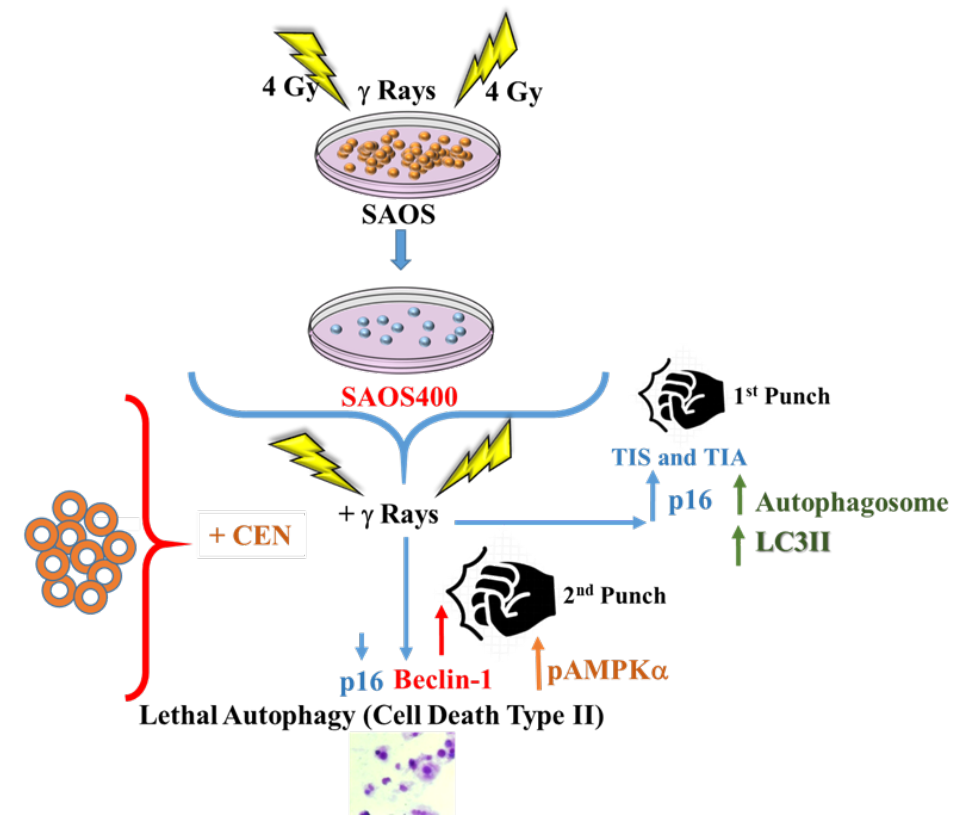
Figure 10. General scheme summarizing data obtained in the SAOS400 cell line after combined treatment with CEN and radiation. Therapy-induced autophagy and senescence can be seen as double-edged sword in the context of radioresistance: They can represent a form of contrast to cell death, but also a ‘therapeutic vulnerability’ process. These processes can evolve in a new field of study that can be explored with both natural molecules and extracts enriched with natural bioactive molecules.